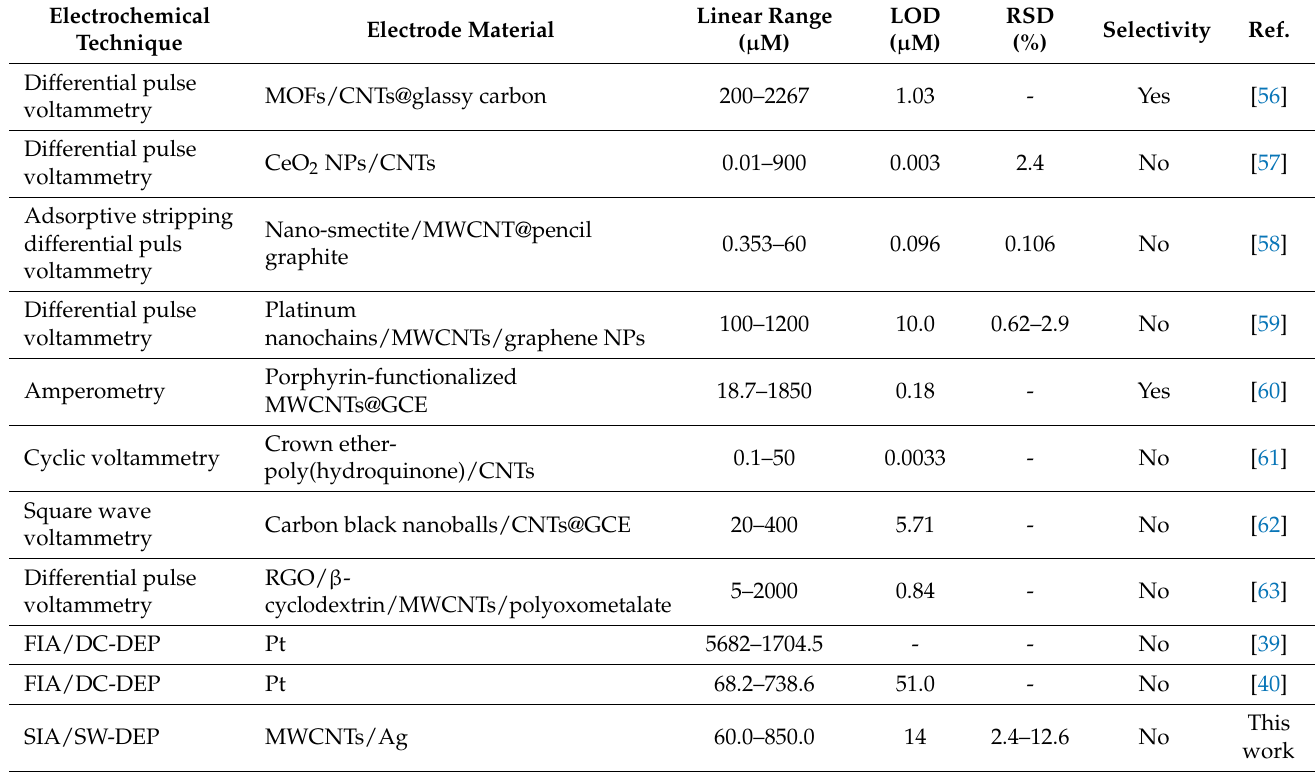
Table 2. The performance of electrodes consists of CNTs for determination of ascorbic acid using different electrochemical